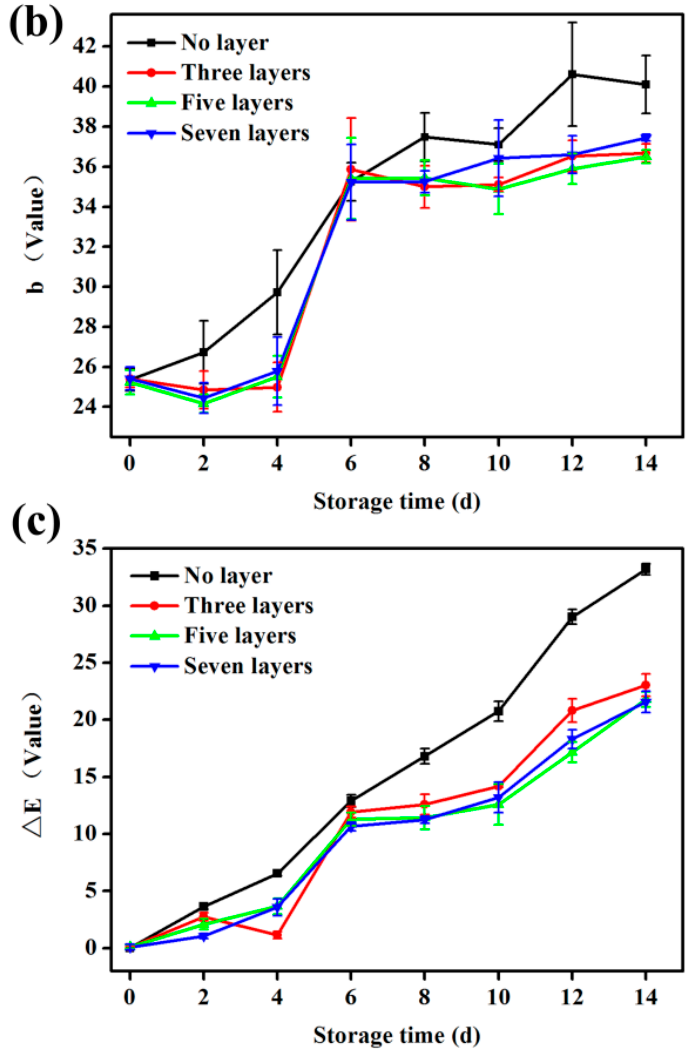
Figure 7. ( a ) Changes in the appearances of mangoes after 14 days of storage; ( b ) variations in chromaticity values (b value) during mango storage; ( c ) changes in colour during mango storage. Error bars represent the standard deviation of three